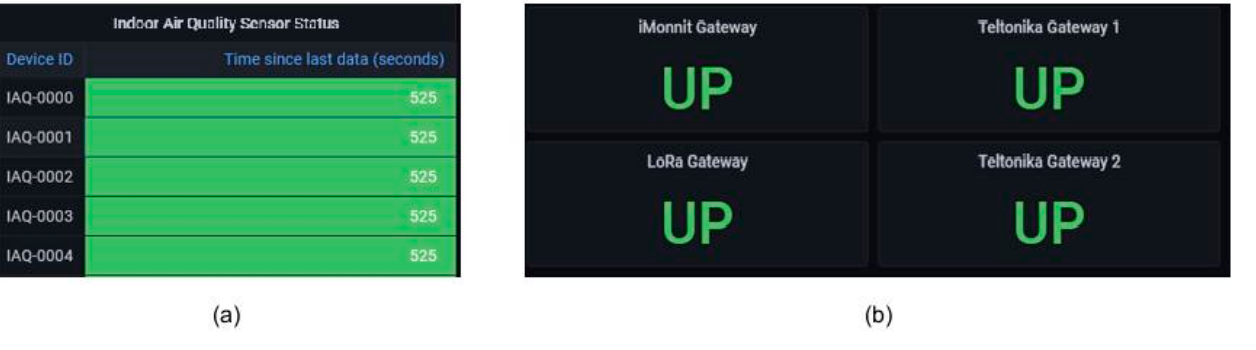
Figure 12. Device Status Dashboard sample: ( a ) Indoor Air Quality Sensor last reading and ( b ) current status of gateway devices.